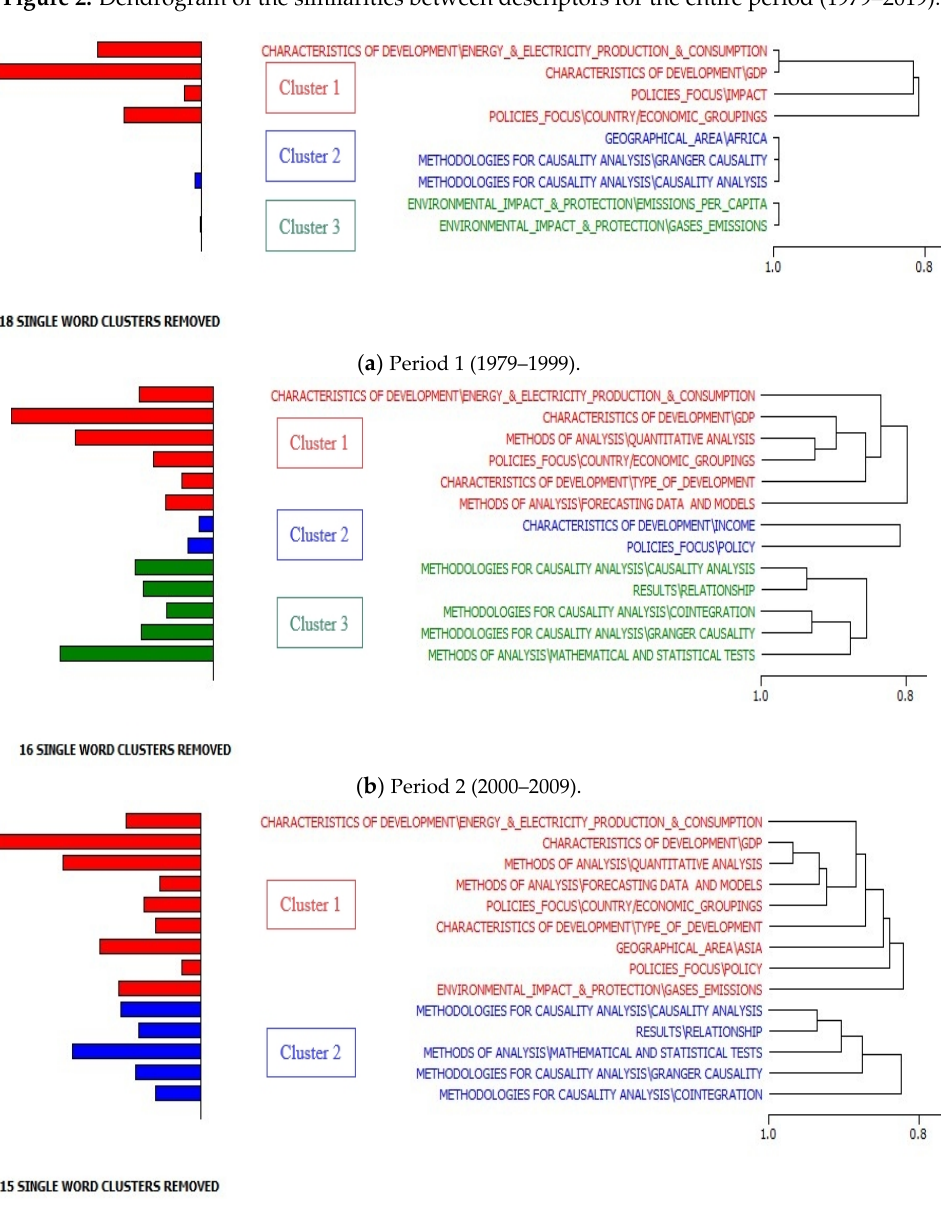
Figure 3. Dendrogram of the similarities between descriptors for each period.